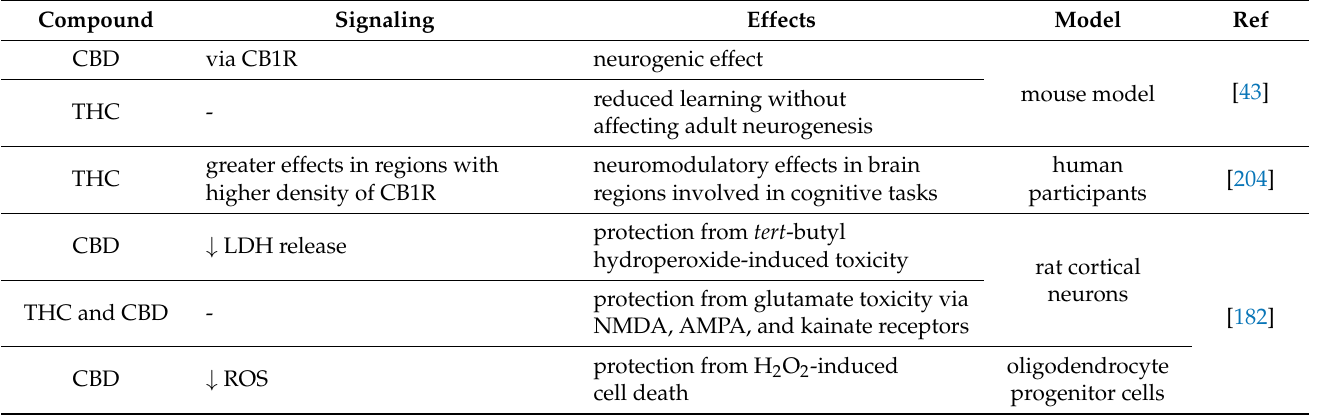
Table 3. Antioxidant and anti-inflammatory effects of phytocannabinoids in neurodegenerative